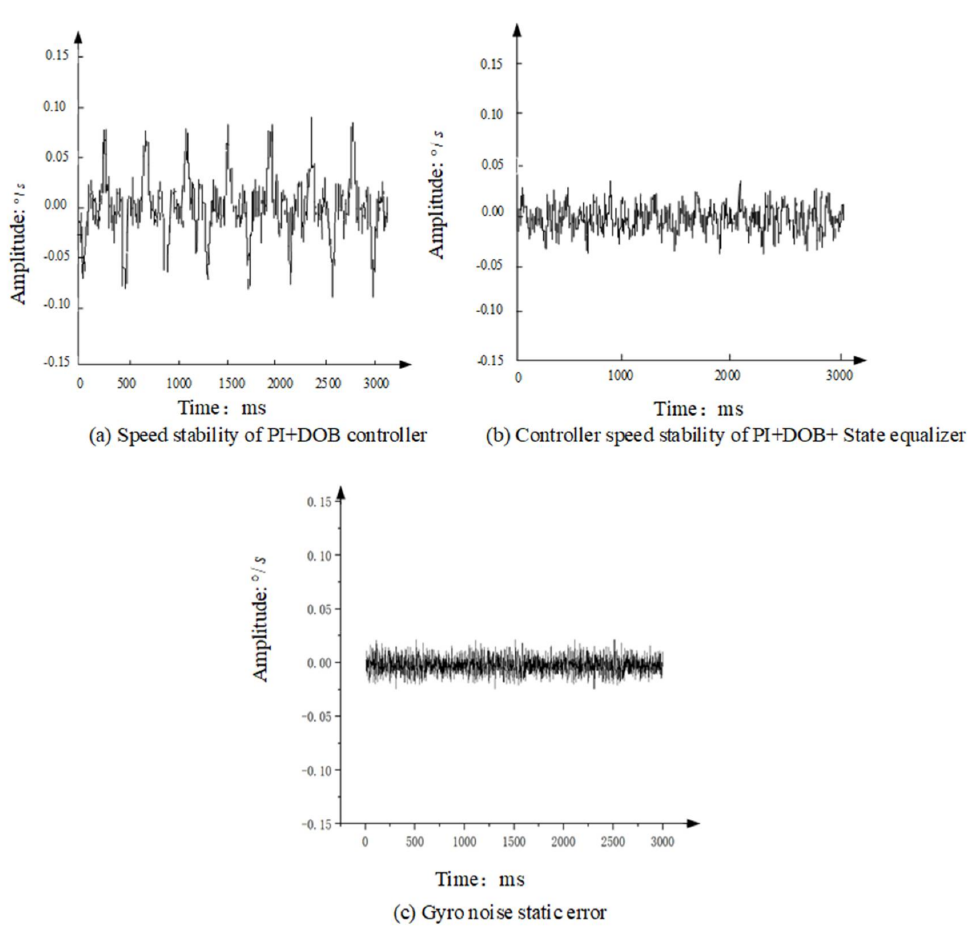
Figure 15. Comparison of speed stability